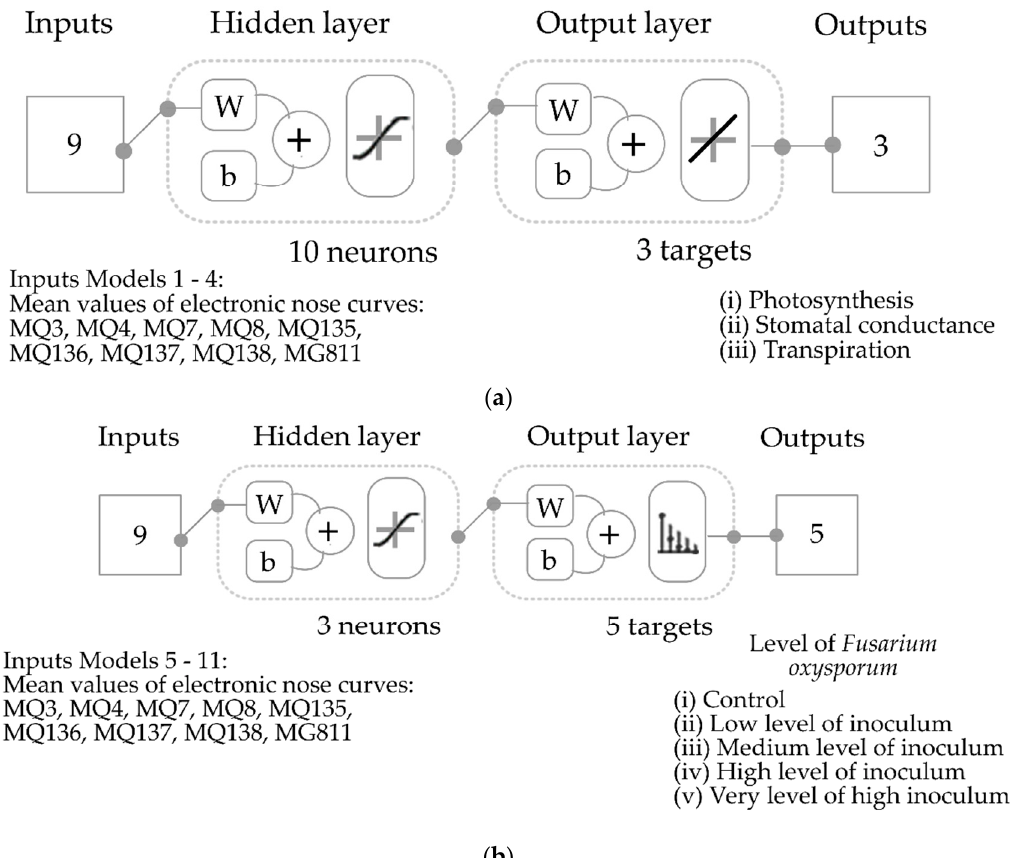
Figure 2. Diagrams of machine learning models based on artificial neural networks showing ( a ) the regression models 1–4, ( b ) pattern recognition models 5–11. Abbreviations: W: weights and b: bias; MQ3: alcohol; MQ4: methane; MQ7: carbon monoxide; MQ8: hydrogen; MQ135: ammonia/alcohol/benzene; MQ136: hydrogen sulfide; MQ137: ammonia; MQ138: benzene/alcohol/ammonia; MG811: carbon